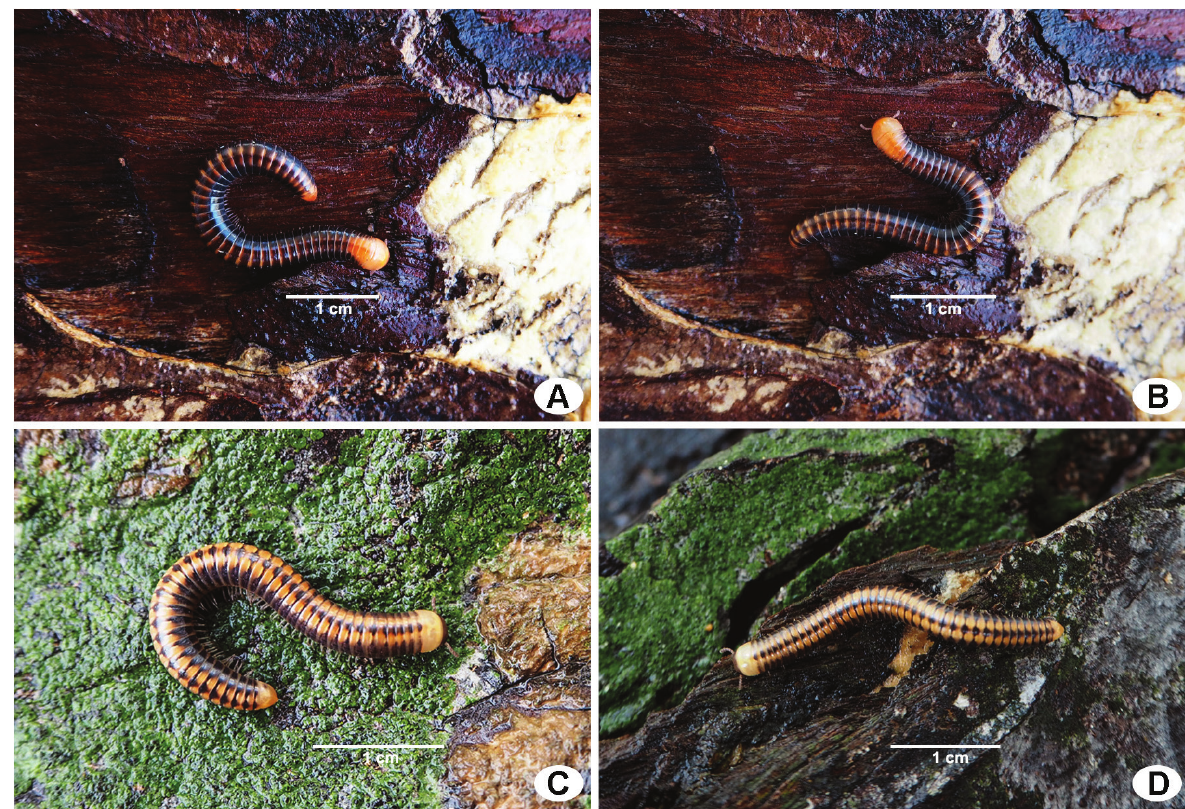
Figure 6. Live Siliquobolellus gen. nov. species from Thailand. A, B. S. amicusdraconis gen. et sp. nov. (from Hub Pa Tard), female (paratype, CUMZ-D00149-2); C, D. S. prasankokae gen. et sp. nov. (from Pha Thai), male (holotype, CUMZ-D00148-1).